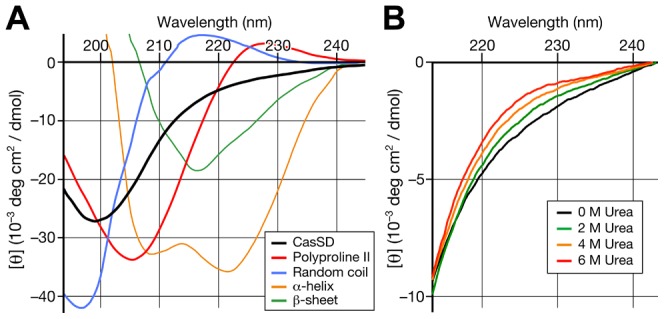
Circular dichroism (CD) spectra of CasSD.(A) CD spectrum of CasSD at 0.2 mg/mL concentration in 10 mM sodium phosphate pH 7.8 (black line). Standard spectra for reference samples with known secondary structures are also given for comparison. Thin orange: α-helix; Thin green: β-sheet; Red: polyproline II; Blue: random coil. (B) Increase of molar ellipticity in the 220–240 nm region of the CasSD CD spectrum with increasing concentration of urea.